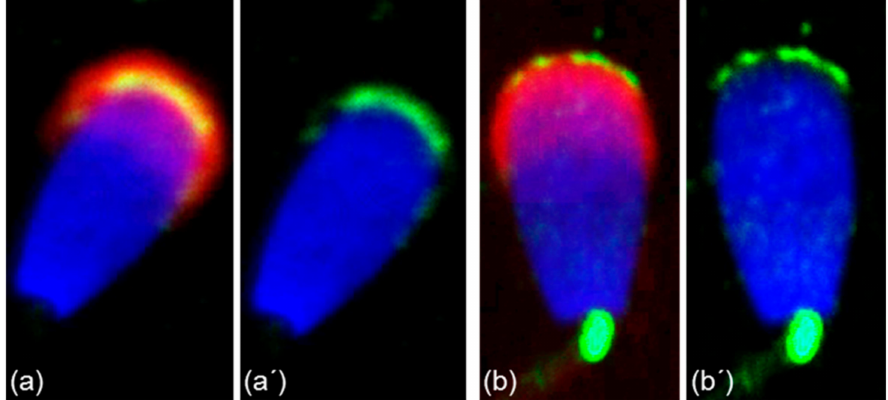
Figure 6. Di ff erent localization of ESR1 and ESR2 in freshly ejaculated bull spermatozoa shown by confocal microscopy. Spermatozoa treated with anti-ESR1 antibody HC-20 (green) ( a , a ’), spermatozoa treated with anti-ESR2 antibody H-150 (green) ( b , b ’). Nuclear DNA was stained by DAPI (blue), and sperm acrosomes were detected by PNA lectin